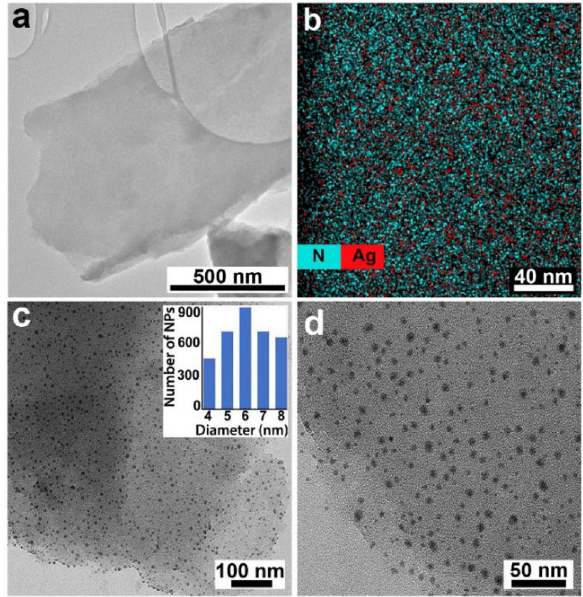
Figure 1. ( a ) HRTEM image of the GCN/Ag + precursor. ( b ) Combined chemical mapping of nitrogen and silver on the graphene surface. ( c , d ) TEM images of GCN/Ag and size distribution of the AgNPs (inset in panel c ).